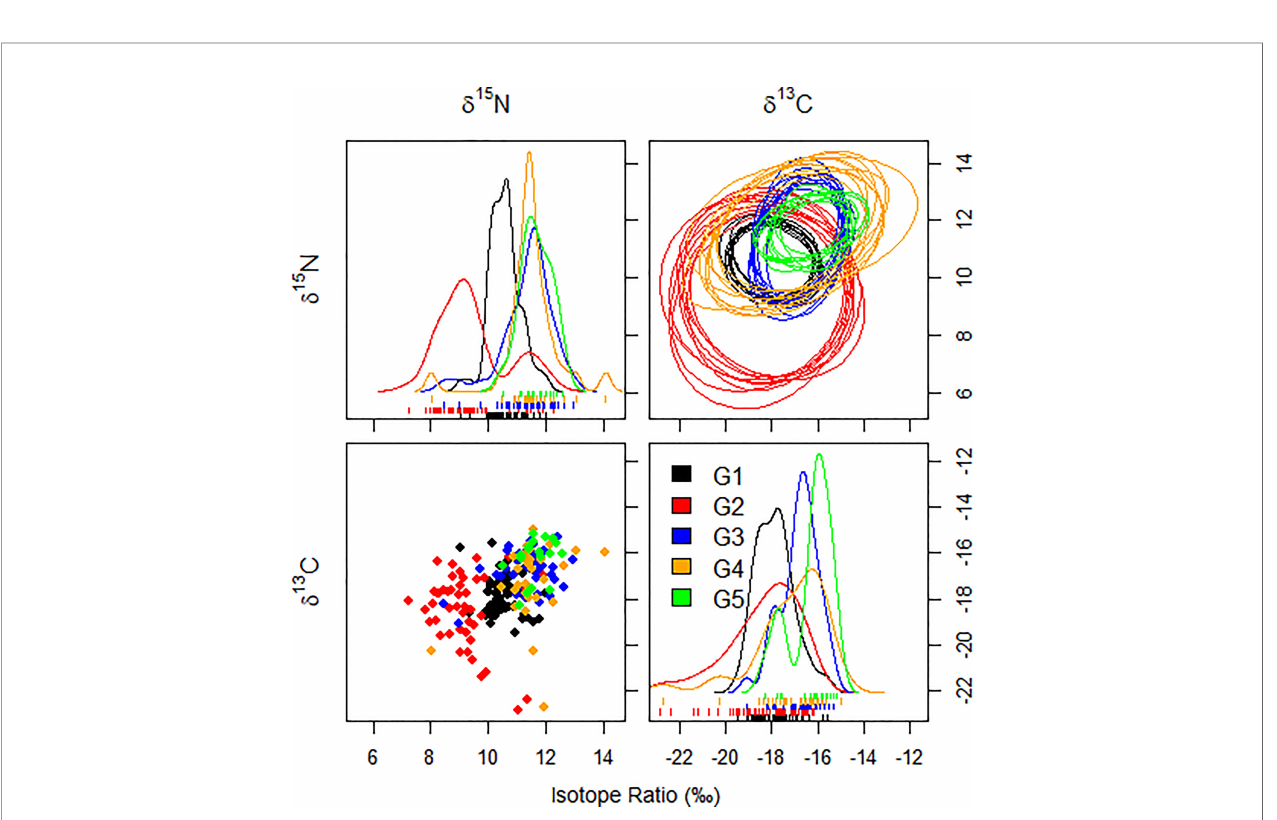
FIGURE 4 | Ten random elliptical projections of the trophic niche region (NR) for each species of sciaenid fi sh collected from the Zhoushan Archipelago between 2019 and 2020, as well as a pair of isotopes (elliptical plots). Also displayed are one-dimensional density plots (lines) and two-dimensional scatterplots.